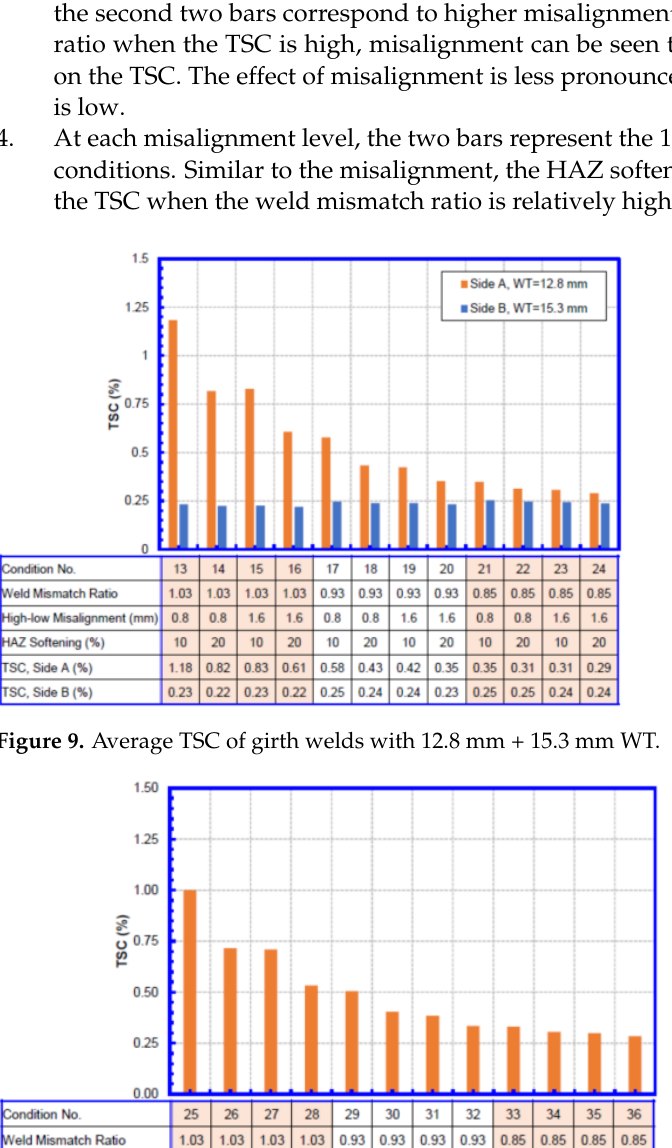
Figure 11. Average TSC of girth welds with 12.8 mm + 18.4 mm WT. The interpretation of the TSC of girth welds joining pipes of different wall thickness, as shown in Figures 8 and 9, is worthy of special attention. When a girth weld with differ- ent wall thickness is pulled in the longitudinal direction, more deformation goes to the weaker side than the stronger side. In these cases, more deformation goes to the side with a thinner wall. The thicker side does not go into plastic condition, resulting in strains be- low 0.25%. The impact on the deformation on the thin side by the various parameters is similar to that of girth welds joining pipes of equal wall and thickness. When the TSC from girth welds joining pipes of different wall thickness is used in integrity assessment, the strain demand and strain capacity should be compared on the same of girth weld. The side with a thinner wall would have greater strain demand than the thicker side. The high strain demand and TSC on the thin side allow for consistent integrity assessment. 3.5. Sensitivity Analysis of Parameters